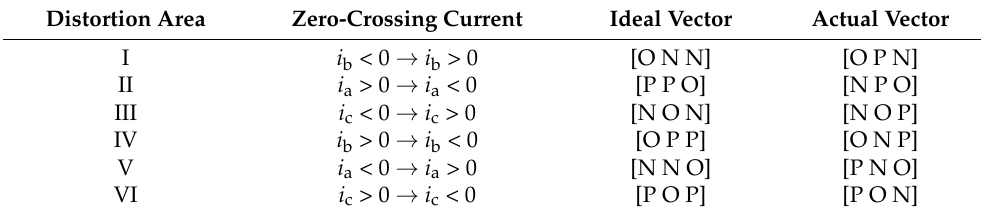
Table 1. Redundant Vector Replacement